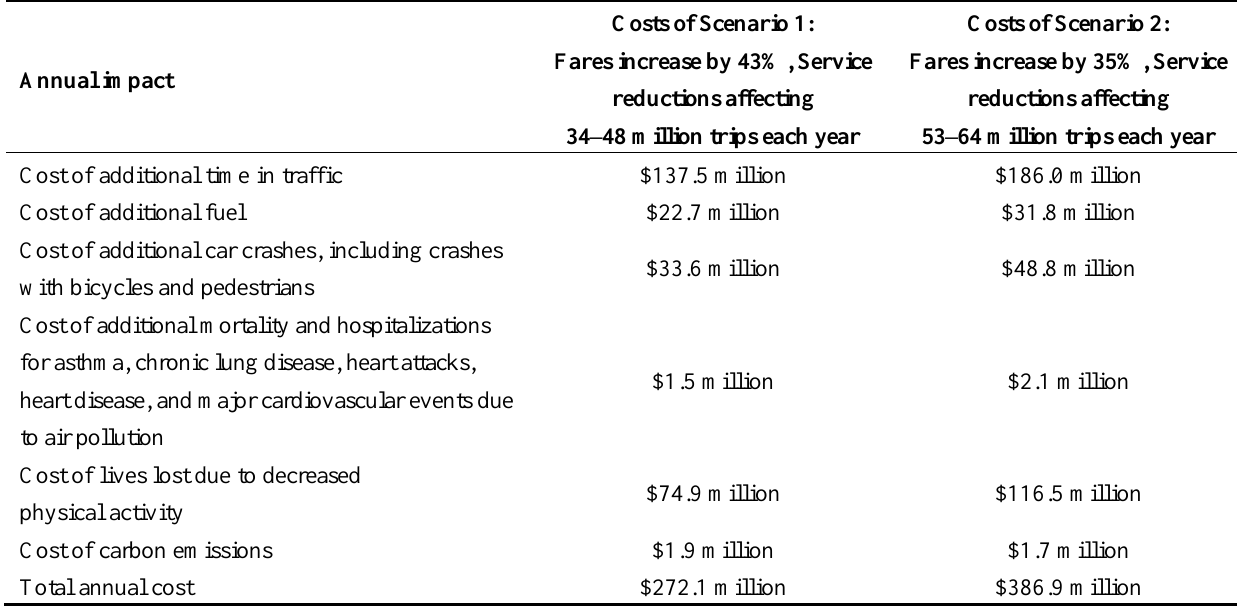
Table 2. Summary of health and economic costs under proposed public transportation service cuts and fare